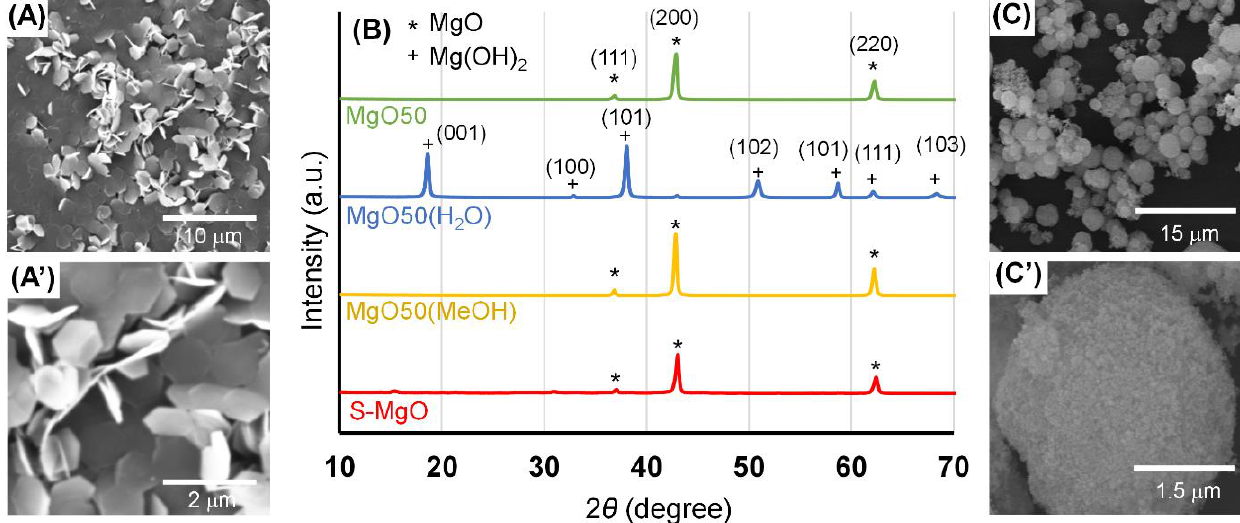
Figure 2. Characterization of the MgO feeding slurries and the spray-dried particles. ( A ) SEM image of dried feeding slurry of MgO/water (MgO50(H 2 O)) and ( A’ ) its high-magnification SEM image; ( B ) XRD patterns; ( C ) SEM image of the spray-dried MgO particles of which dispersion media is methanol (S-MgO) and ( C’ ) its high-magnification SEM image.